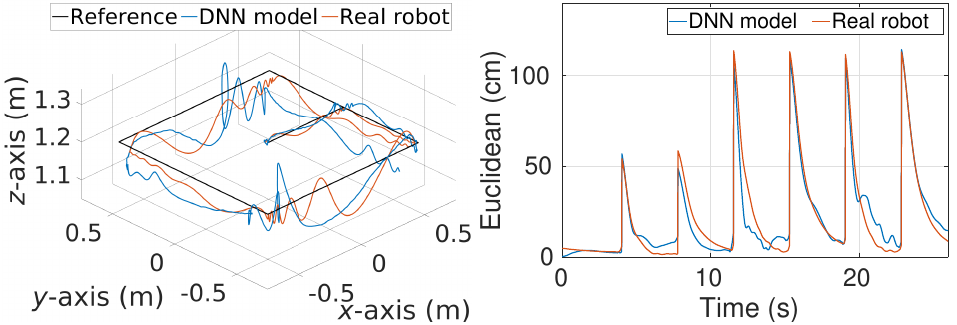
Figure 4. Sequential-setpoints tracking performance of the weight set obtained from simulation tuning. ( Left ): 3D view of the sequential-setpoints and tracked trajectories. ( Right ): resulting Euclidean error over the DNN model and the real